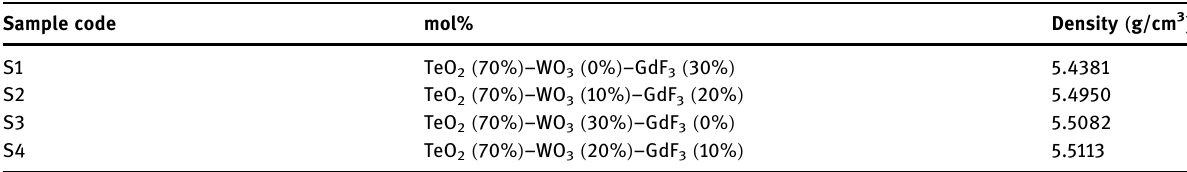
Table 1: Four di ff erent proportions of TeO 2 – WO 3 – GdF 3 glass system with their density values Sample